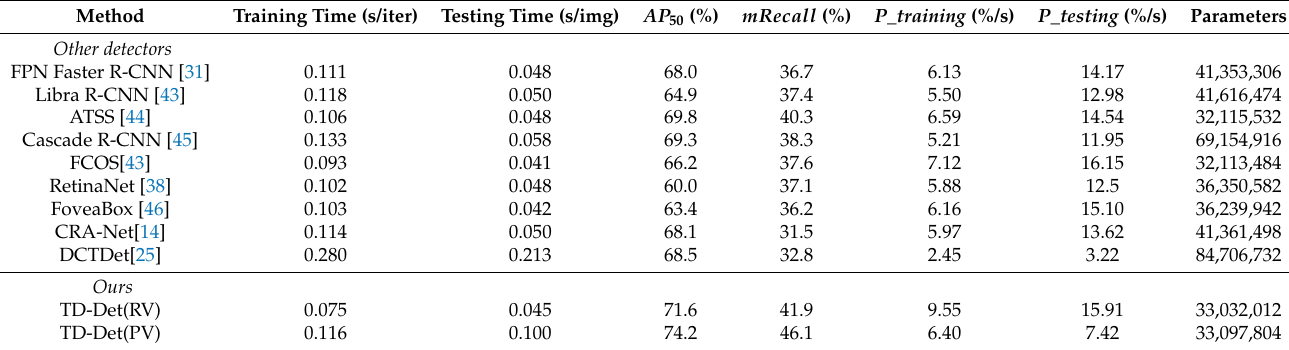
Table 3. The efficiency